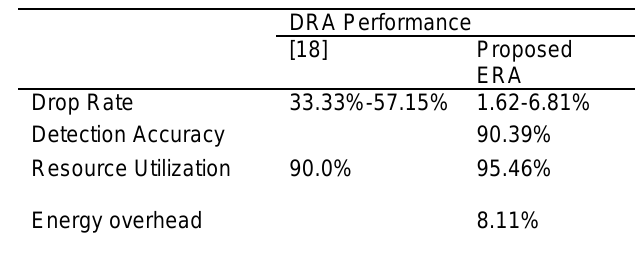
Table 1: Performance comparison of DRA